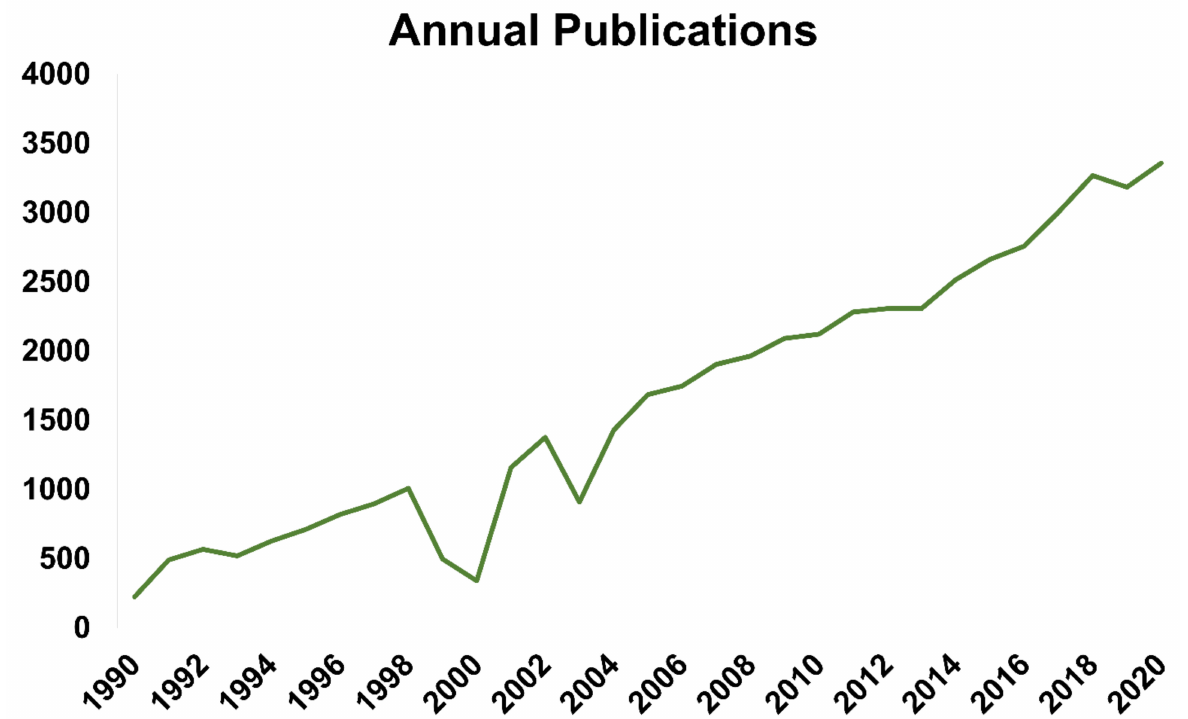
Figure 1. The total number of publications per year during the period